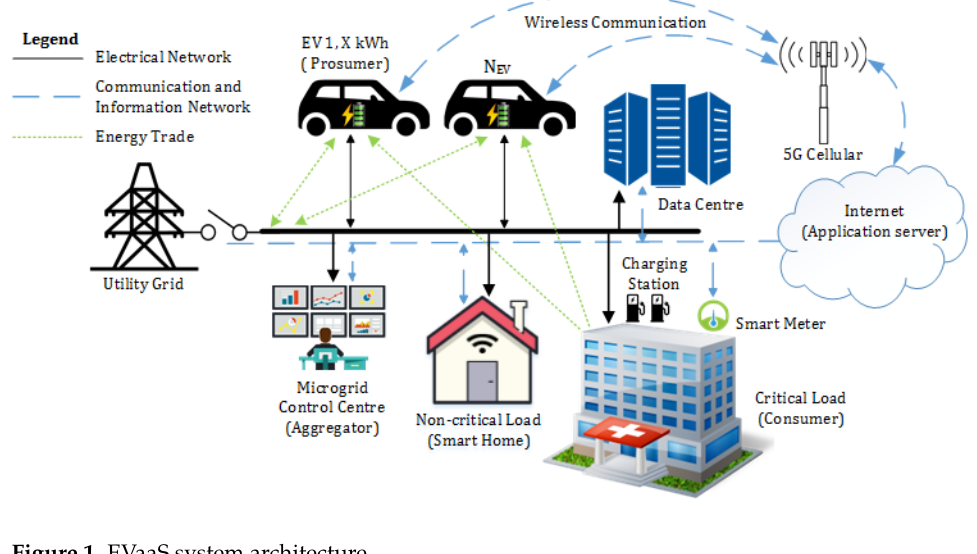
Figure 1. EVaaS system